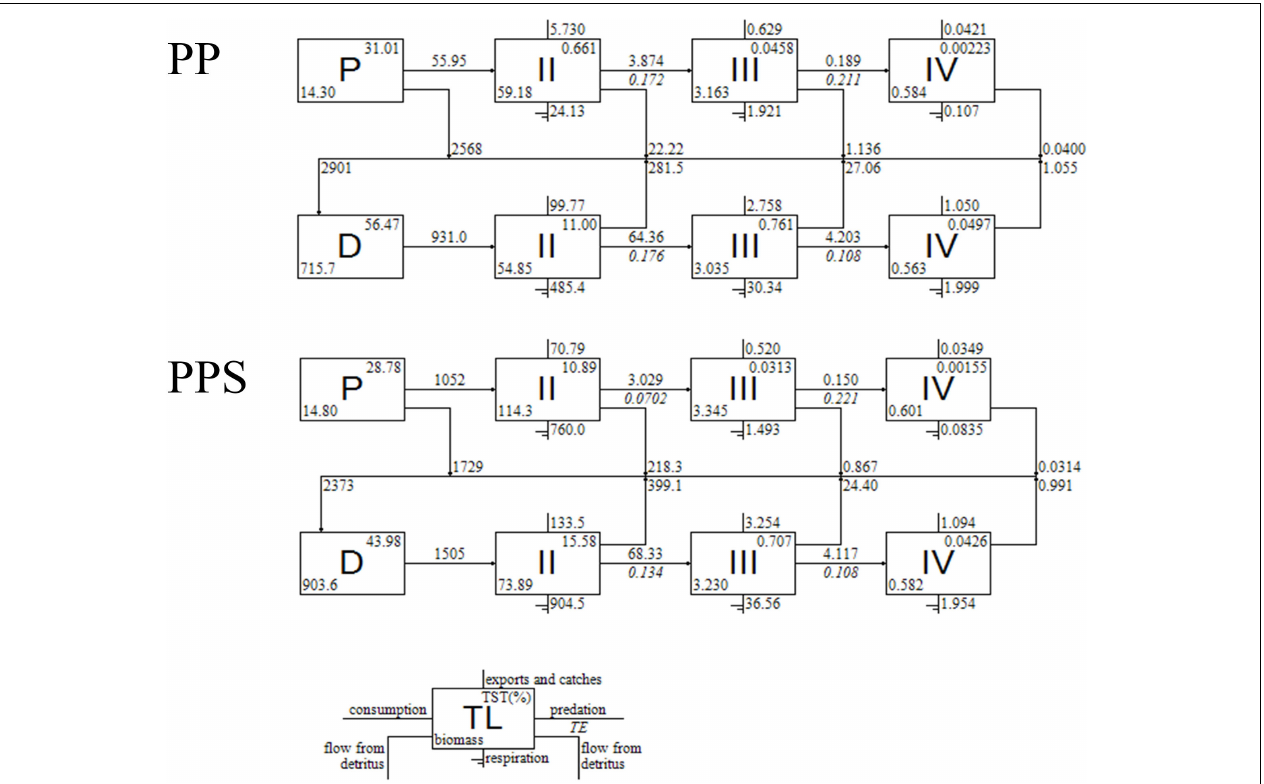
FIGURE 1 | Energy flows among different trophic levels in the two integrated pond aquaculture ecosystems. PP, the integrated pond aquaculture ecosystem of Portunus trituberculatus – Penaeus japonicus ; PPS, the integrated pond aquaculture ecosystem of Portunus trituberculatus – Penaeus japonicus – Sinonovacula constricta ; D, detritus; P, primary producers; TL, trophic level; TE, transfer efficiency, TST, total system